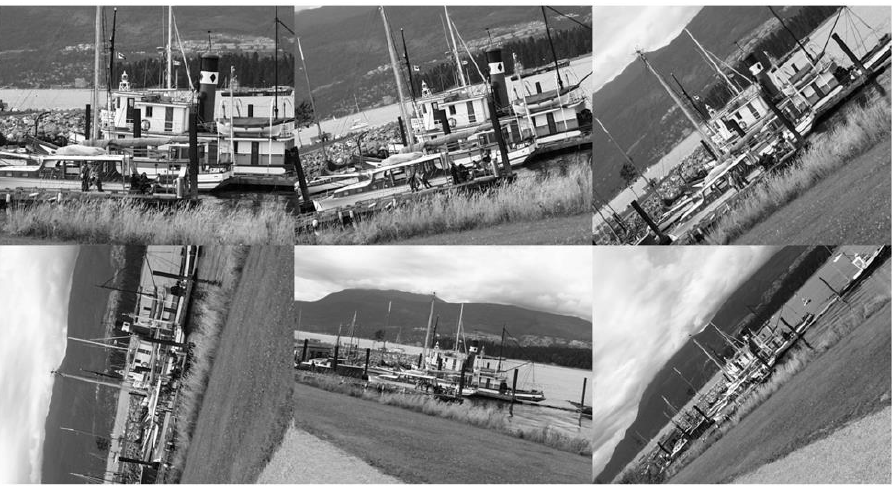
ffi ne dataset. Electronics 2020 , 9 , x FOR PEER REVIEW